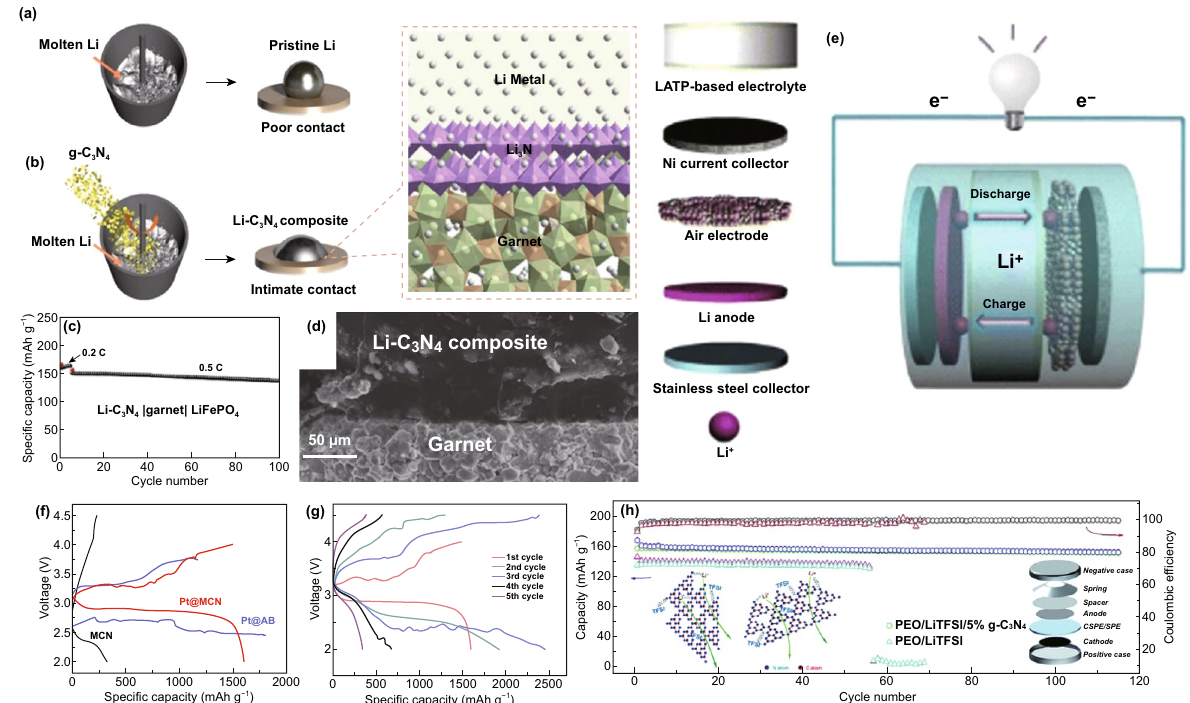
Fig. 27 a Schematic illustration of the synthesis process of Li-C 3 N 4 composite and the interfacial contact comparison of Li/garnet and Li-C 3 N 4 / garnet. a Garnet SSE presents a lithiophobic surface that forms pristine Li droplets. b Li-C 3 N 4 composite shows an intimate contact with garnet and a Li 3 N layer is in situ formed at the interface. c Cycling performance of Li-C 3 N 4 |garnet|LiFePO 4 full cell at a current rate of 0.5 C. d SEM images of the cross sections of Li-C 3 N 4 /garnet interfaces. Reproduced with permission from Ref. [165]. e Scheme of the configuration of the MCN-based electrode solid-state lithium-air battery. f Charge and discharge curves of the first cycle of the prepared air electrodes at a current density of 0.02 mA cm −2 . g Cycling performance of Pt@MCN electrode at a current density of 0.02 mA cm −2 . Reproduced with permission from Ref. [166]. h Capacity and coulombic efficiency versus cycle number for solid-state batteries using SPE and 5% g-C 3 N 4 CSPE at 0.2 C rate. Inset: Schematics of enhanced lithium-ion migration in g-C 3 N 4 CSPE. Reproduced with permission from Ref. [167]. Copyright permissions from Wiley–VCH, Springer Nature and Royal Society of Chemistry. (Color figure